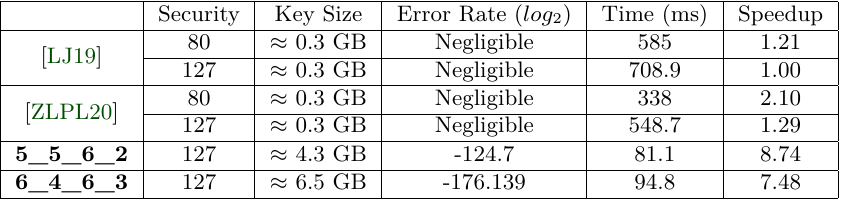
Table 8: Comparison between implementations of an 8-bit addition